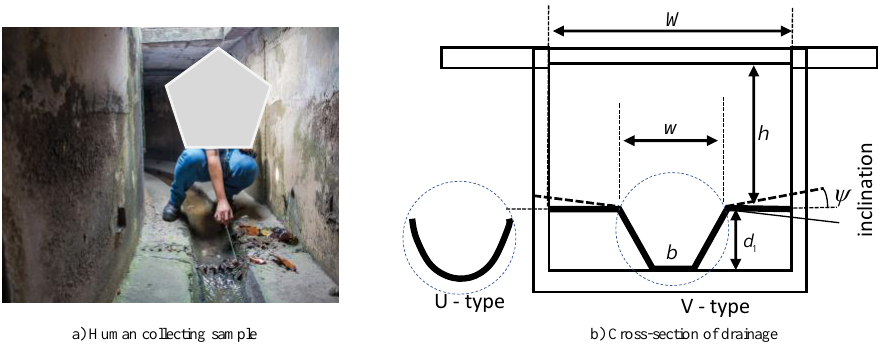
Figure 1. Human collecting water samples inside the drain commonly found in Singapore